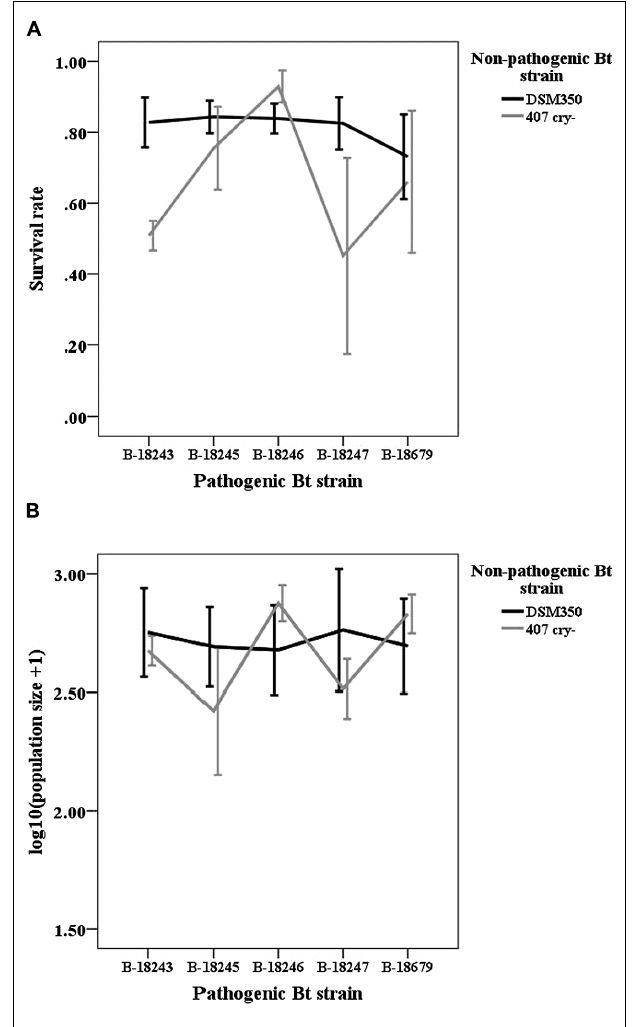
FIGURE 2 | Line graphs of (A) survival rate and (B) logarithmic population size of the non-pathogenic-pathogenic mixed treatment. Vertical lines represent the one-fold standard error.